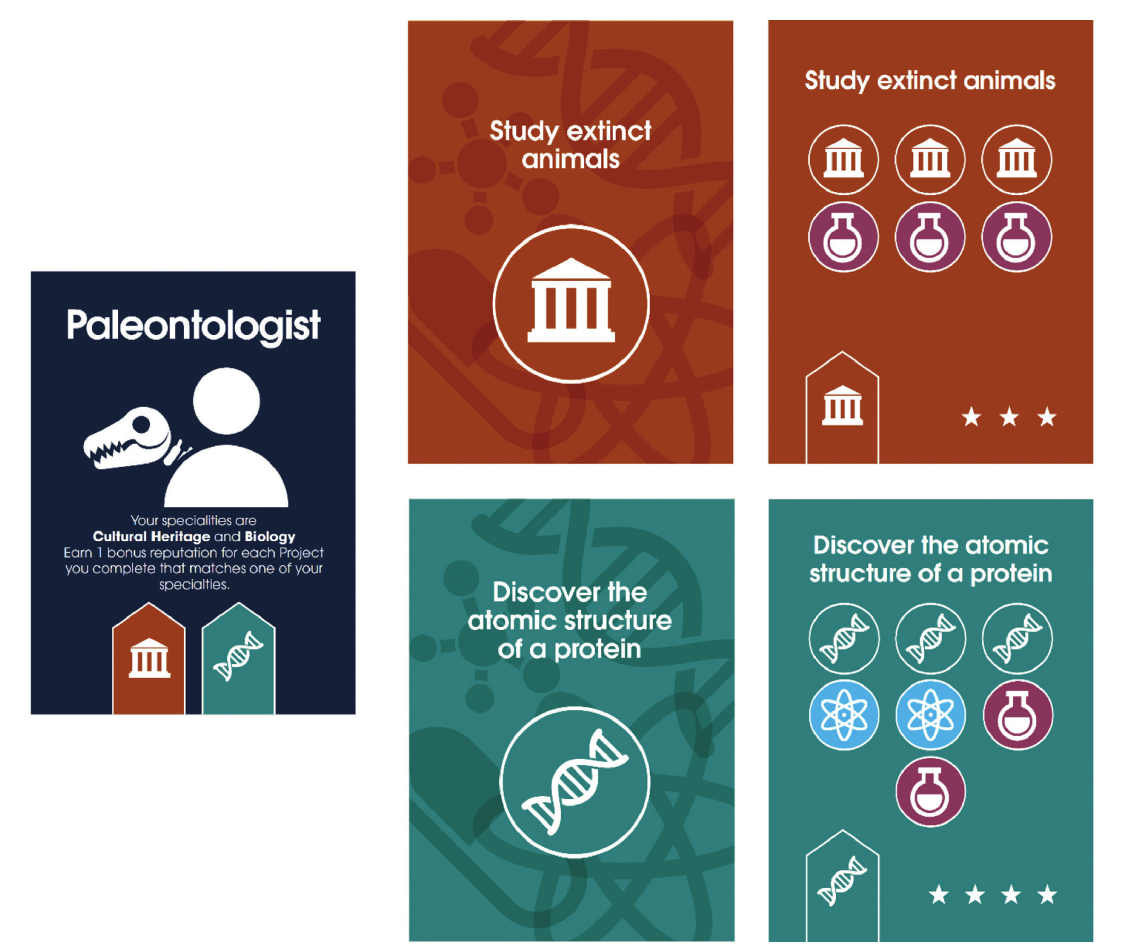
Figure 4. A Paleontologist Scientist card (left), with two Project cards related to their specialties in cultural heritage (middle and right top cards) and biology (middle and right bottom cards). The varying number of science icons needed for the successful completion of the Project are reflected in the number of stars (or ‘fame’) awarded (Source: Authors, 2022; Diamond Light Source,